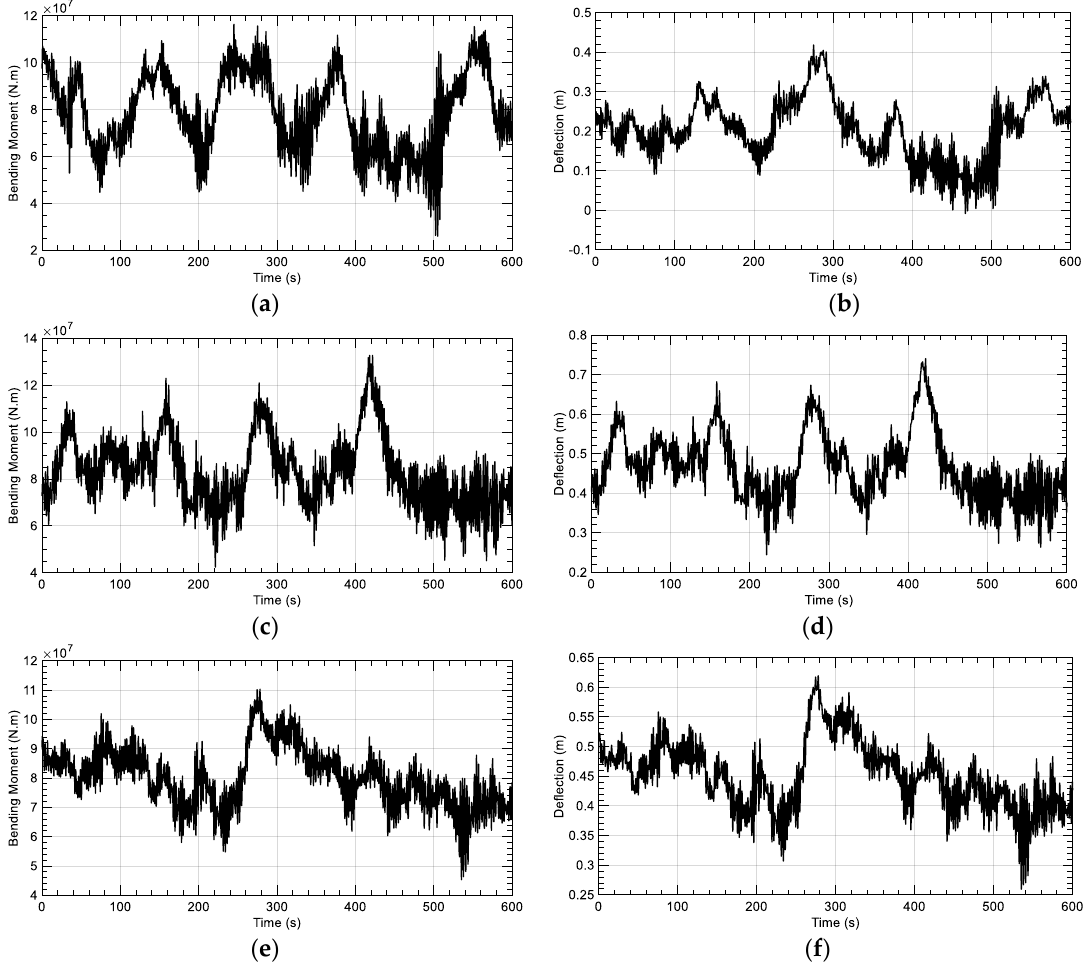
Figure 26. Tower Dynamic Responses; ( a ) Tower-Base Fore-aft Bending Moment, Turb. Class A; ( b ) Tower-Top Fore-aft Deflection, Turb. Class A; ( c ) Tower-Base Fore-aft Bending Moment, Turb. Class B; ( d ) Tower-Top Fore-aft Deflection, Turb. Class B; ( e ) Tower-Base Fore-aft Bending Moment, Turb. Class C; and ( f ) Tower-Top Fore-aft Deflection, Turb. Class C.